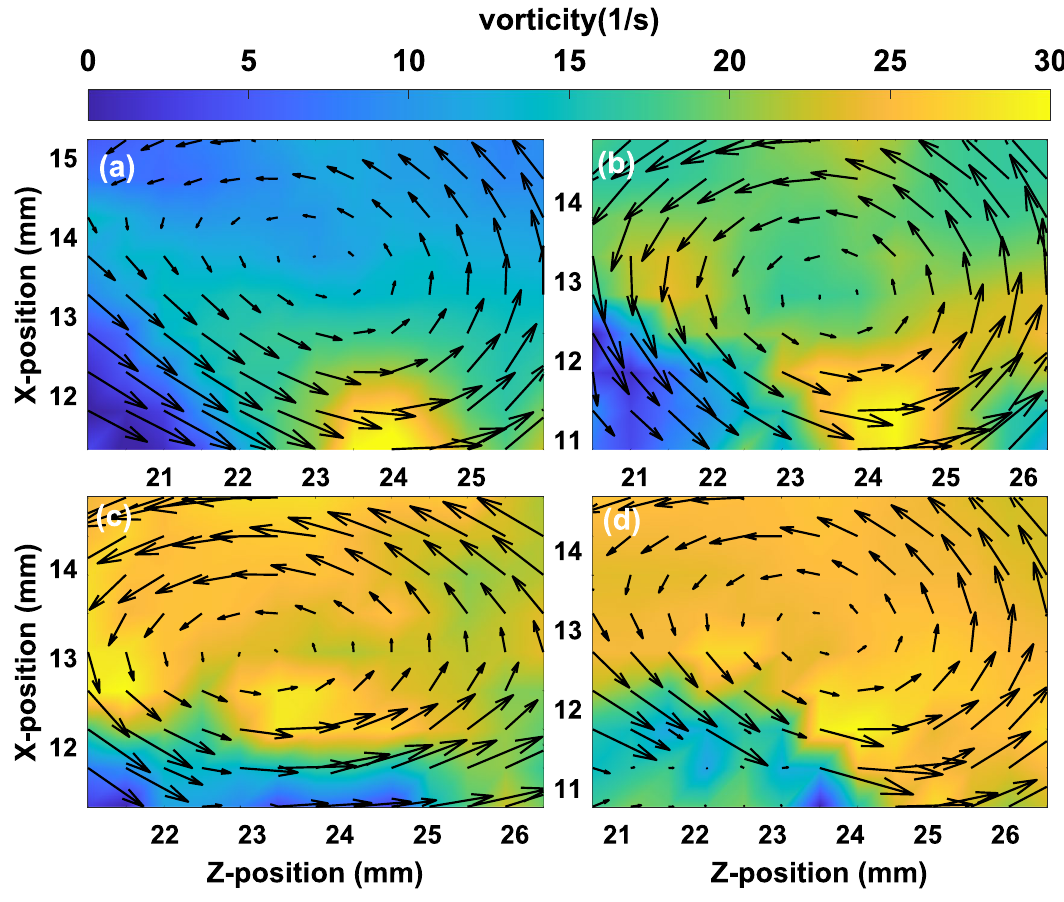
Figure 8. The velocity vectors of the around vortex and the color bar represent the magnitude of vorticity (1/s) at the input pressure ( a ) 200 Pa, ( b ) 300 Pa, ( c ) 350 Pa and ( d ) 400 Pa of pulse valve for two dust layers flow in the opposite